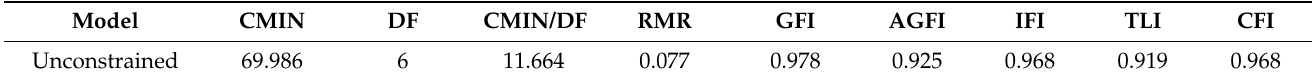
Table 3. Model fit summary.